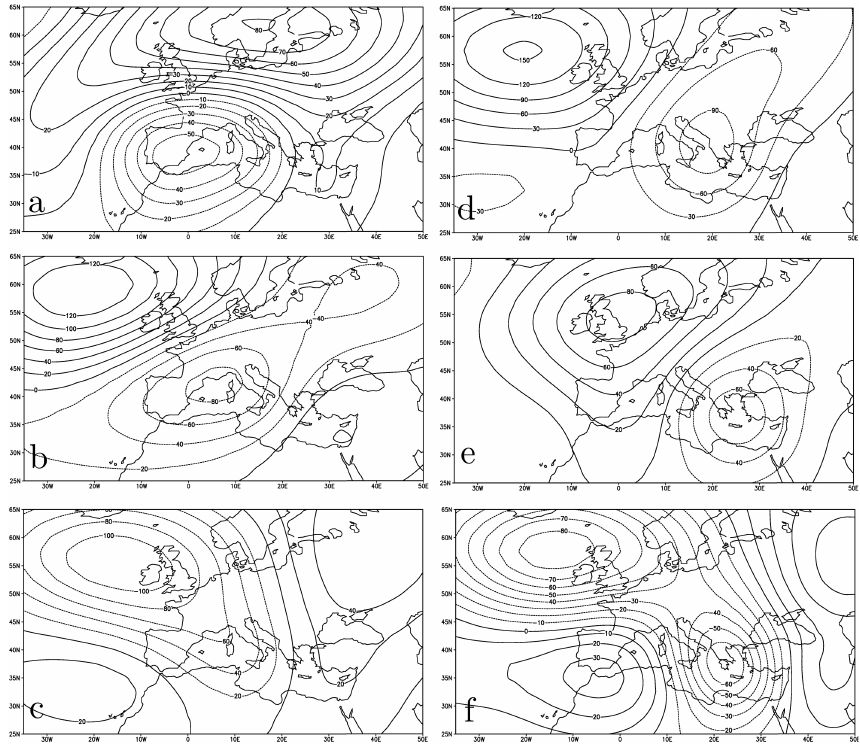
Fig. 3. Identified patterns of Z500 anomalies associated with extreme precipitation. The left panel refers to the western Mediterranean, while the right panel refers to the eastern